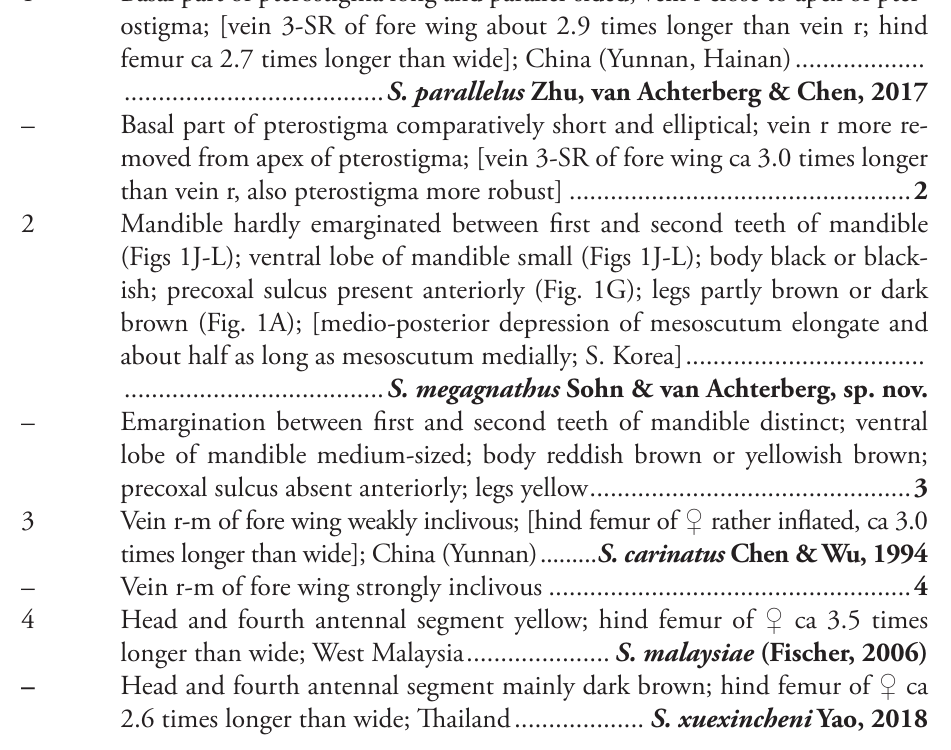
Fig. 1A–L Type material. Holotype , ♀ (KNA), S outh K orea , DMZ Botanical Garden, Man- dae-ri, Haean-myeon, Yanggu-gun, Gangwon-do, 38°15'09.3"N,128°06'40.6"E, 20.VI.–4.VII.2017, Shin & Kim leg. GenBank accession number